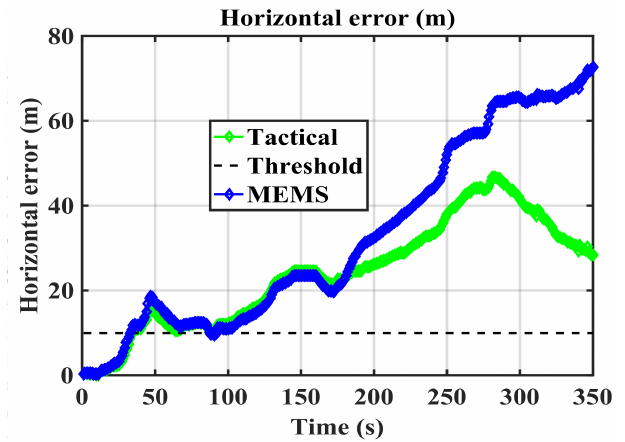
Figure 6. RIO mechnization errors for the two different IMUs shown in Figure 4.